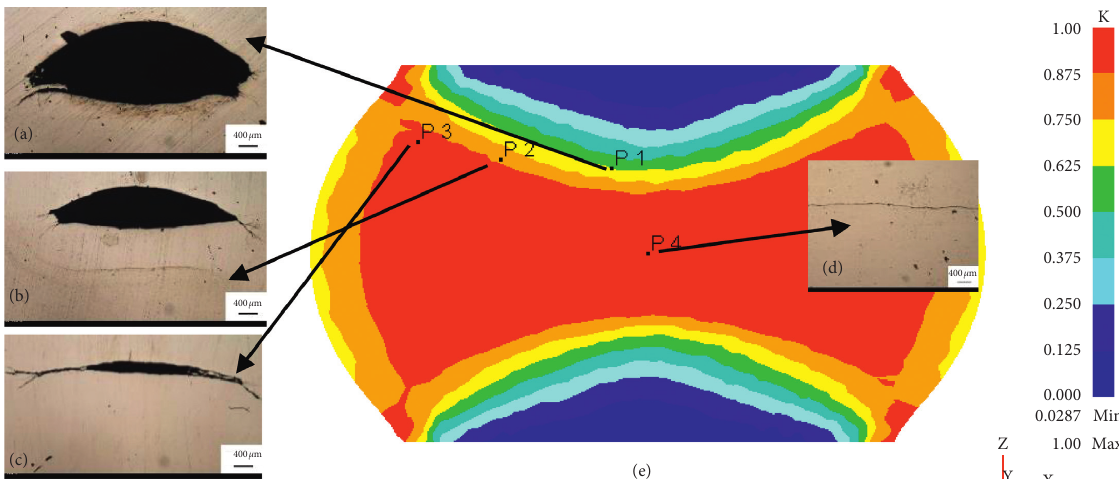
Figure 8: When the deformation of the Φ 60mm × 80mm cylinder is 40%, (a) P1, (b) P2, (c) P3, (d) P4 the experimental results, and (e) simulation results of the void closed.